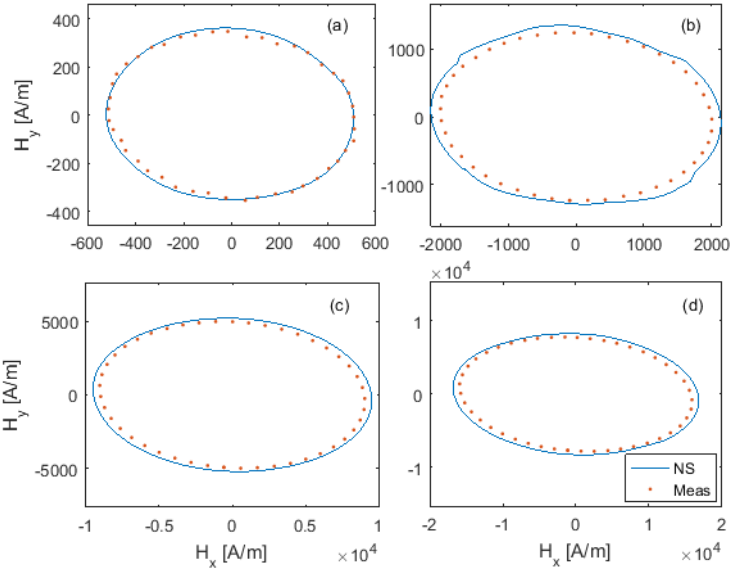
Figure 8. Comparison between simulated and measured trajectories of the H field relative to the elliptic loops, where AR = 0.75 for the following values of the major half-axis: Bx = 10 mT ( a ), Bx = 100 mT ( b ), Bx = 400 mT ( c ), and Bx = 600 mT ( d ).